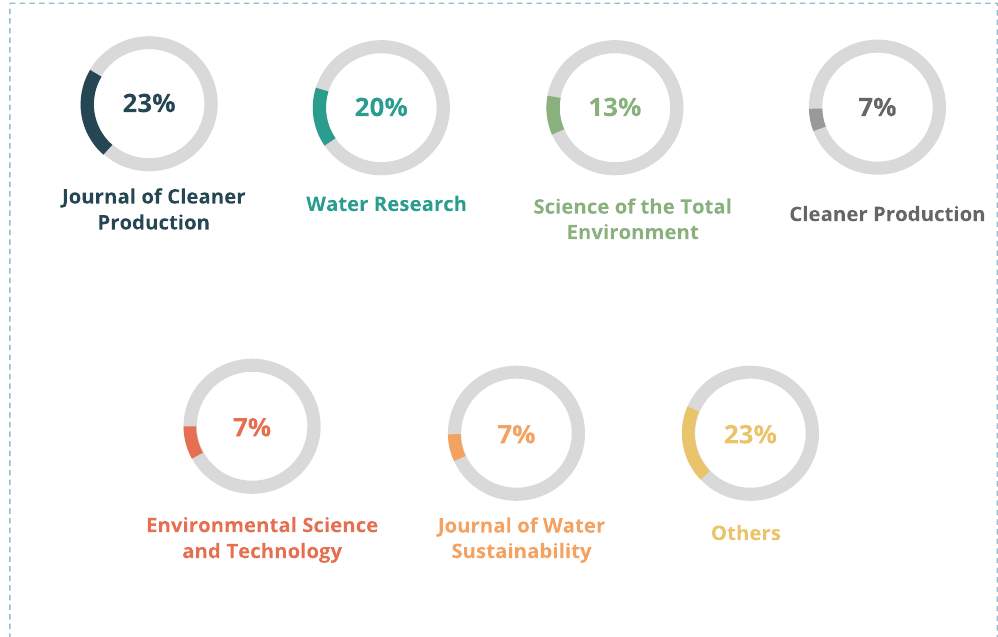
Figure 6. Published LCA studies on WWTP from various journals.